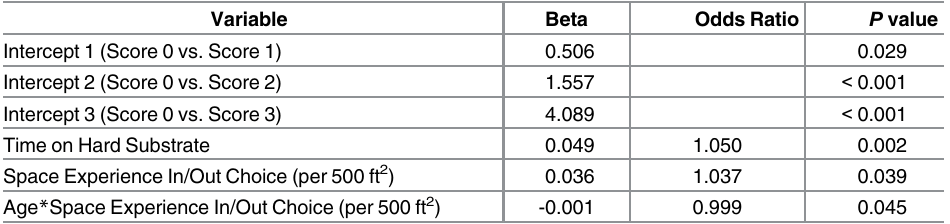
Table 5. Multivariable assessment of MS scores using multinomial logistic regression.